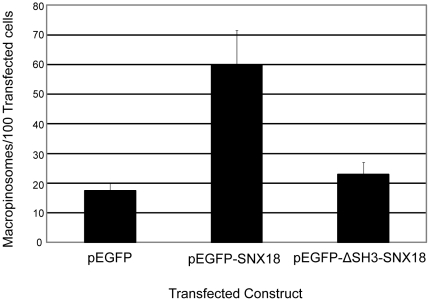
The SH3 domain of SNX18 is required for elevation of macropinosome formation.HEK-Flp-In cells transiently overexpressing pEGFP, pEGFP-SNX18, or pEGFP-ΔSH3-SNX18 were assayed for macropinosome formation as described in Materials and Methods. The mean number of macropinosomes/100 transfected cells was quantitated over 3 replicates of 500 transfected cells for each condition. Error bars denote S.E.M.